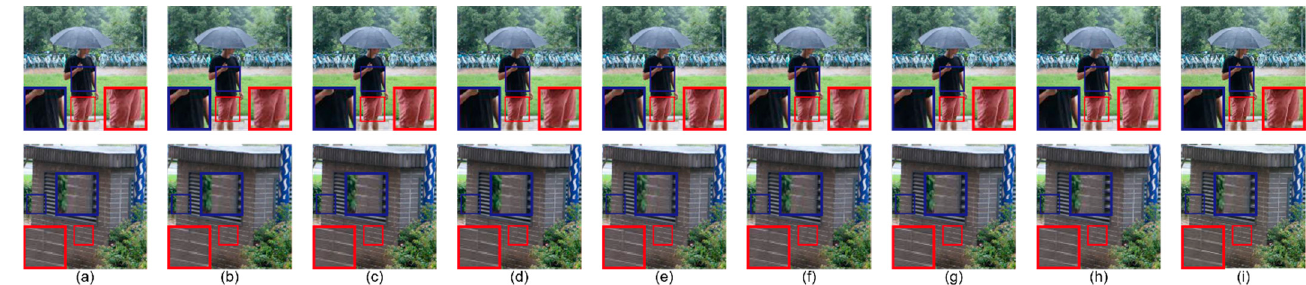
Figure 9. Deraining task performance of the proposed MARCAFNet and state-of-the-art methods when using the real-world dataset. ( a ) Rainy image and results, ( b ) RESCAN, ( c ) PReNet, ( d ) MSPFN, ( e ) MPRNet, ( f ) VRGNet, ( g ) PCNet, ( h ) RAiANet, and ( i ) MARCAFNet.